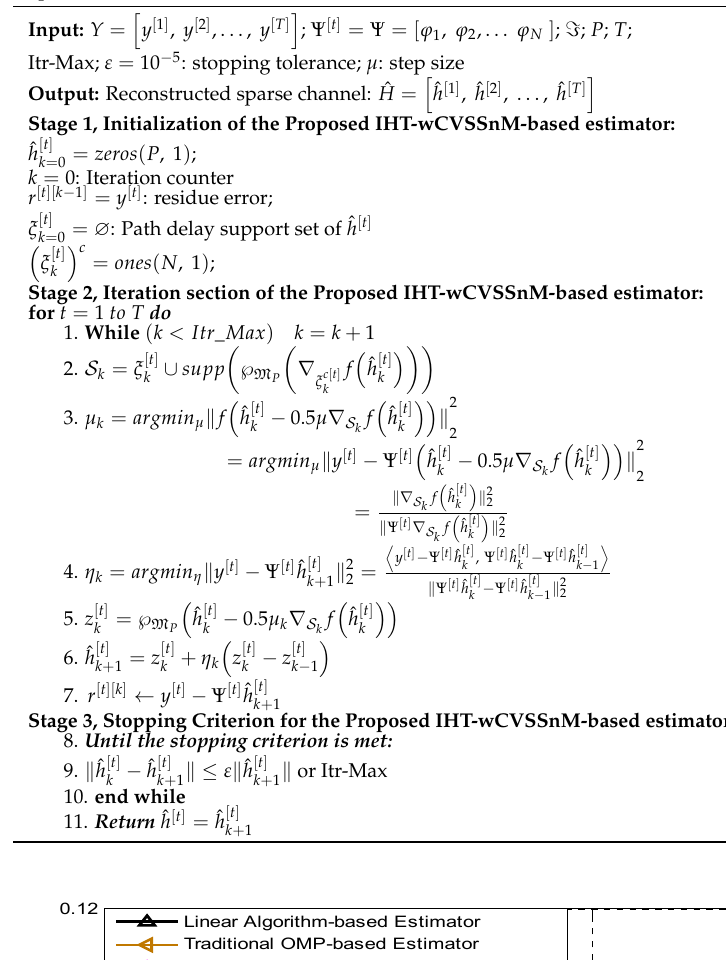
Linear Algorithm-based Estimator Traditional OMP-based Estimator